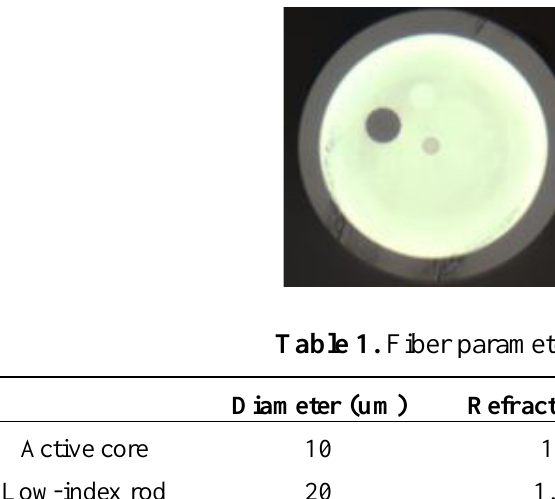
Figure 1. Photograph of the cleaved Tm 3+ -doped silicate fiber.